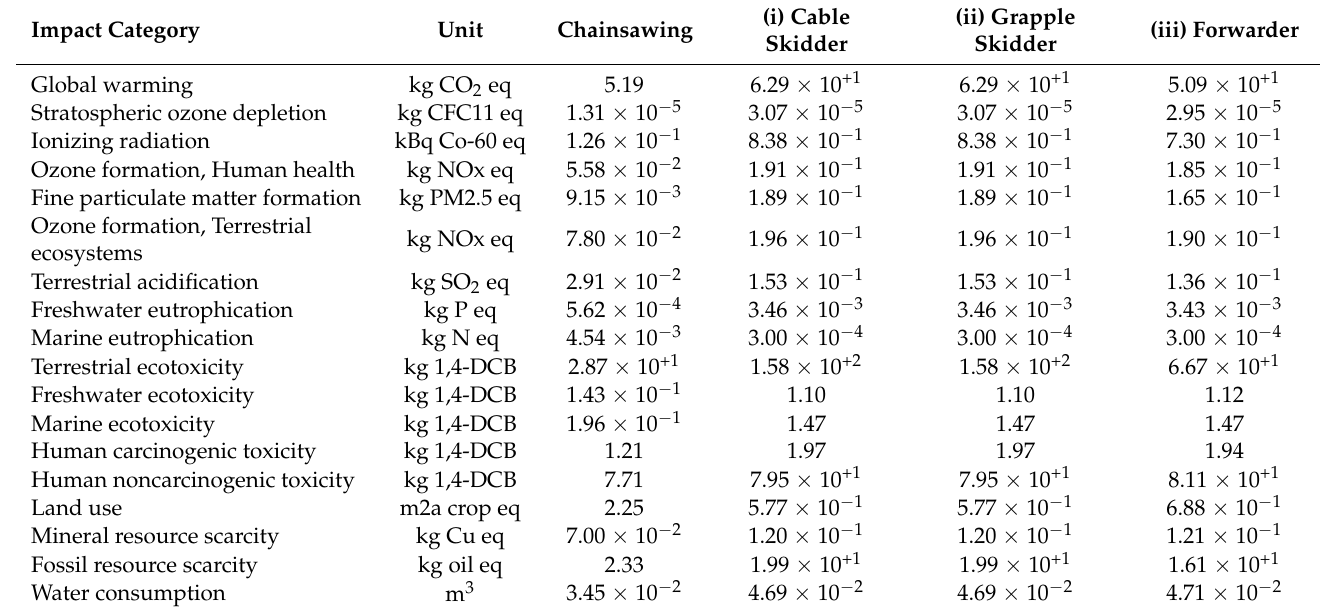
Table 7. Characterisation of the impacts of different logging operations per “1 h of